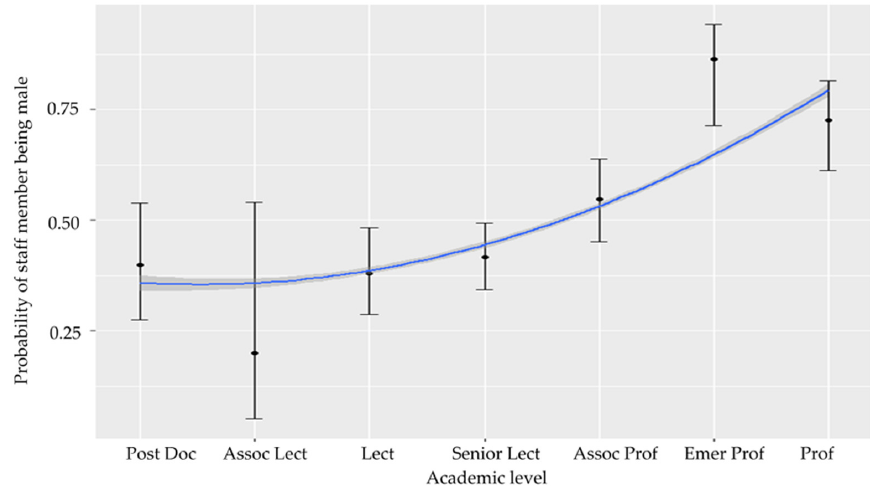
Figure 2. Modelled probabilities of a staff member being male as a function of academic level in Australia/New Zealand. The modelled quadratic term (blue line) is also plotted which includes the standard error (dark grey).